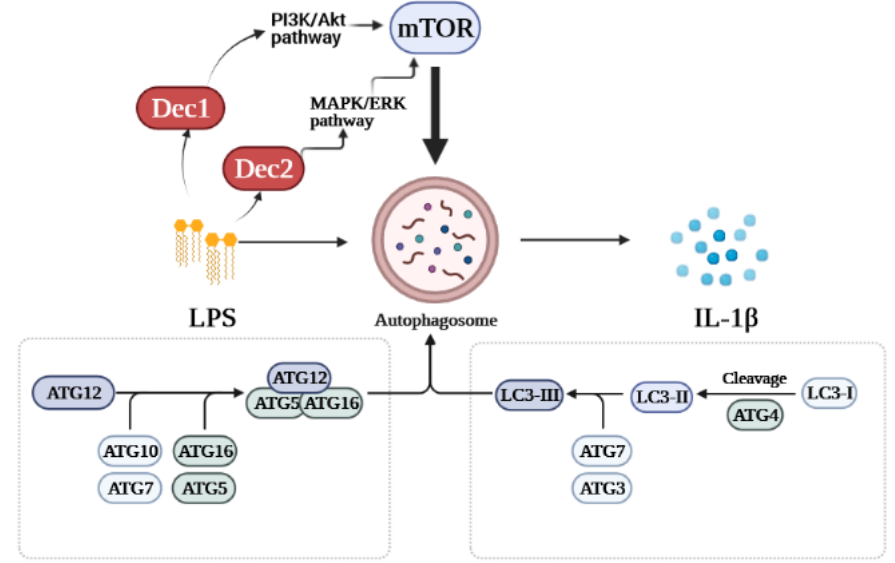
Figure 1. Schematic diagram of the roles of Dec1 and Dec2 in autophagy. Treatment with LPS stimulates the expression of Dec1 and Dec2. Dec1 mediates autophagy via the PI3K/Akt/mTOR pathway, while Dec2 regulates autophagy through the MAPK/ERK/mTOR pathway.